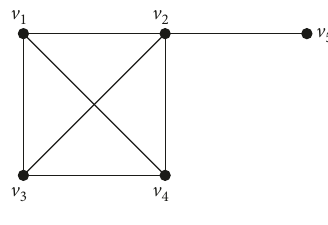
Figure 1: A simple graph G